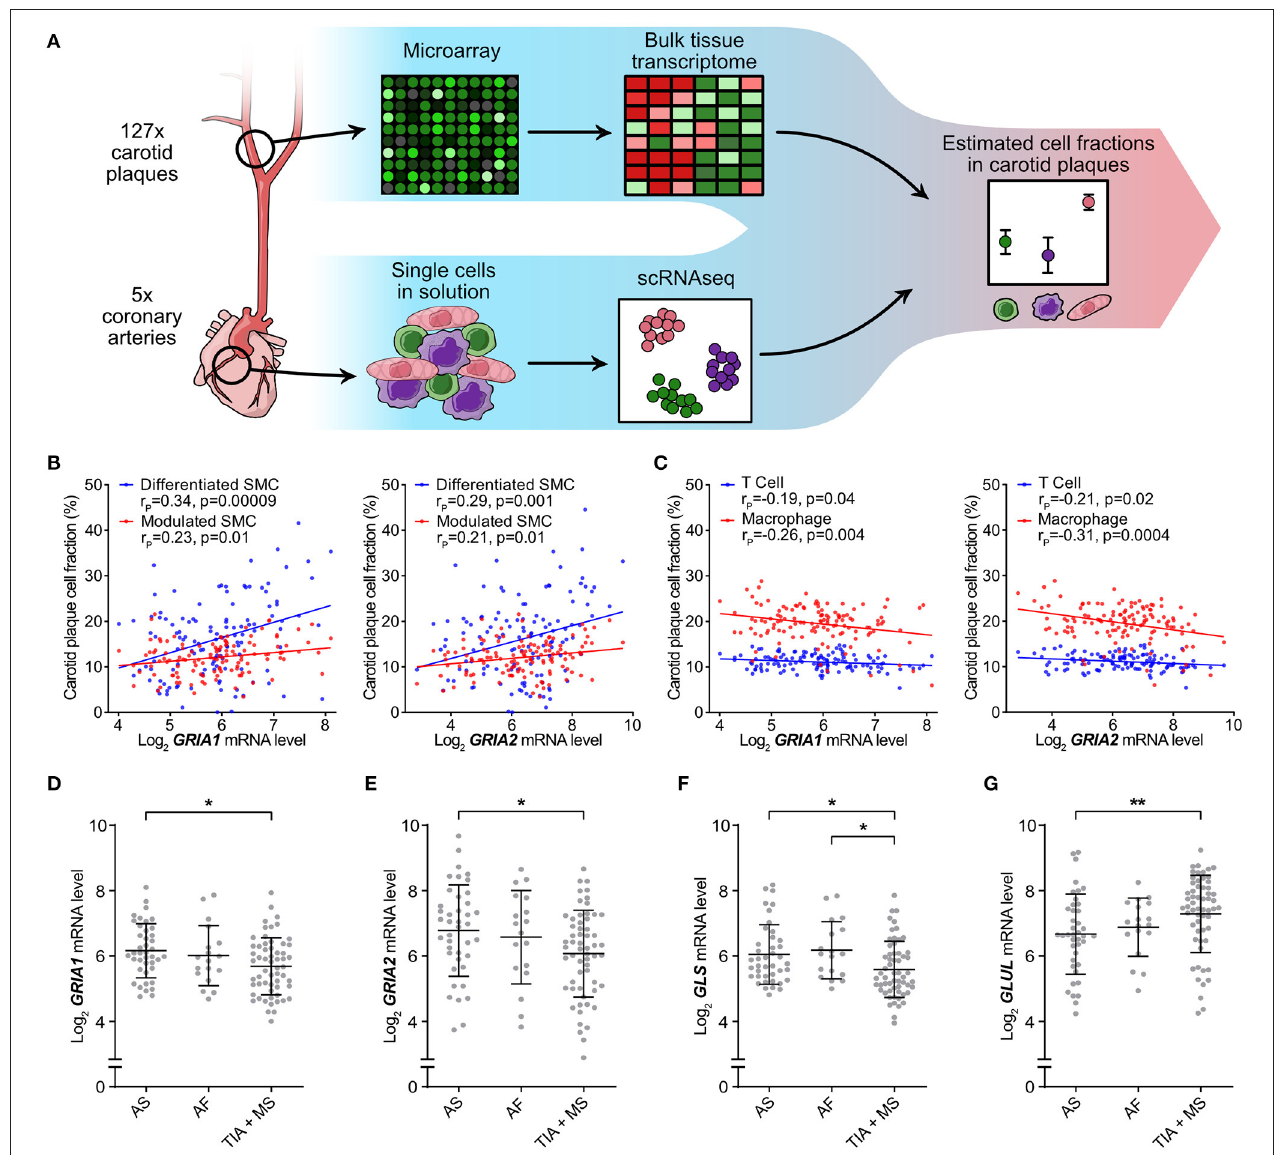
FIGURE 5 | Low AMPA-type Receptor Expression in Carotid Plaques Associated with Adverse Clinical Events. Atheoscelerotic plaque cellular composition in the BiKE cohort was estimated based on microarray data analysis using predefined cellular signatures in atherosclerotic plaques from scRNAseq data. (A) Schematic representation of the microarray data analysis process. (B) Correlation between GRIA1 (left) and GRIA2 (right) mRNA levels and fraction of differentiated (blue) or modulated (red) SMC subtypes in carotid atherosclerotic plaques (r P = Pearson r). (C) Correlation between GRIA1 (left) and GRIA2 (right) mRNA levels and fraction of T cells (blue) and macrophages (red) in carotid atherosclerotic plaques. (r P = Pearson r). (D–G) Dot plots comparing GRIA1 (D) , GRIA2 (E) , GLS (F) , and GLUL (G) mRNA levels between asymptomatic (AS) ( n = 40), amaurosis fugax (AF) ( n = 18), and transient ischemic attack + minor stroke (TIA + MS) ( n = 59) patients. Dots represent the mRNA level for individual patients. The middle bars indicate mean expression and error bars show SD. Differences between groups were analyzed using Kruskal-Wallis ANOVA followed by Dunn’s test. * p < 0.05, ** p <